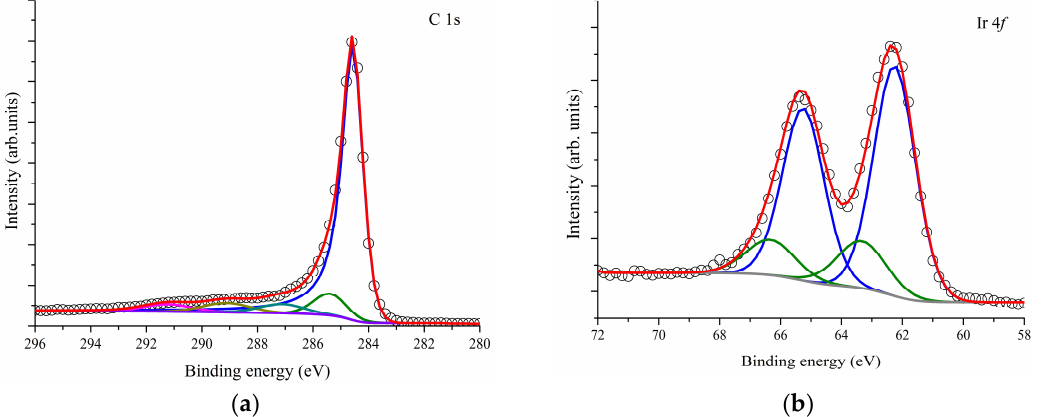
Figure 3. Deconvolution of the C 1s core level peak for bare MWCNTs ( a ). Deconvolution of the Ir 4f core level peak for iridium oxide nanoparticles ( b